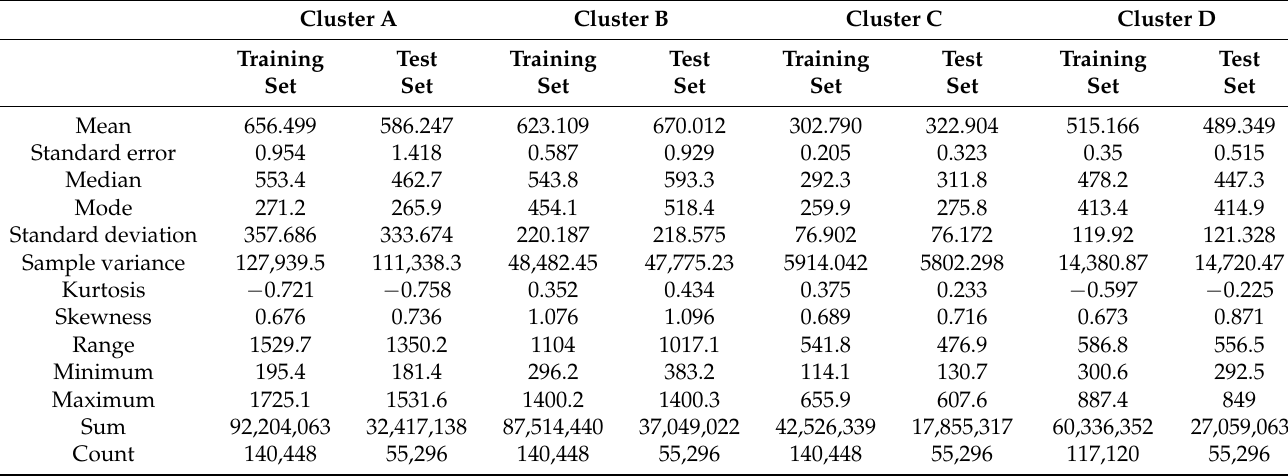
Table 2. Statistical analysis of electricity load data by cluster